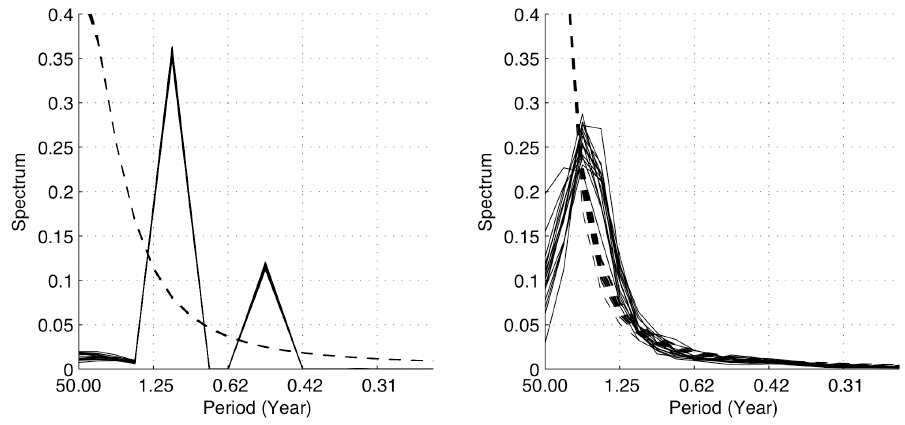
Figure 4. The power spectrums of Global-SST (left) and Nino-SST (right) for 16 2 Fig. 4. The power spectrums of Global-SST (left) and Nino-SST (right) for 16 cases in Experiment 1. cases in Experiment 1. 3